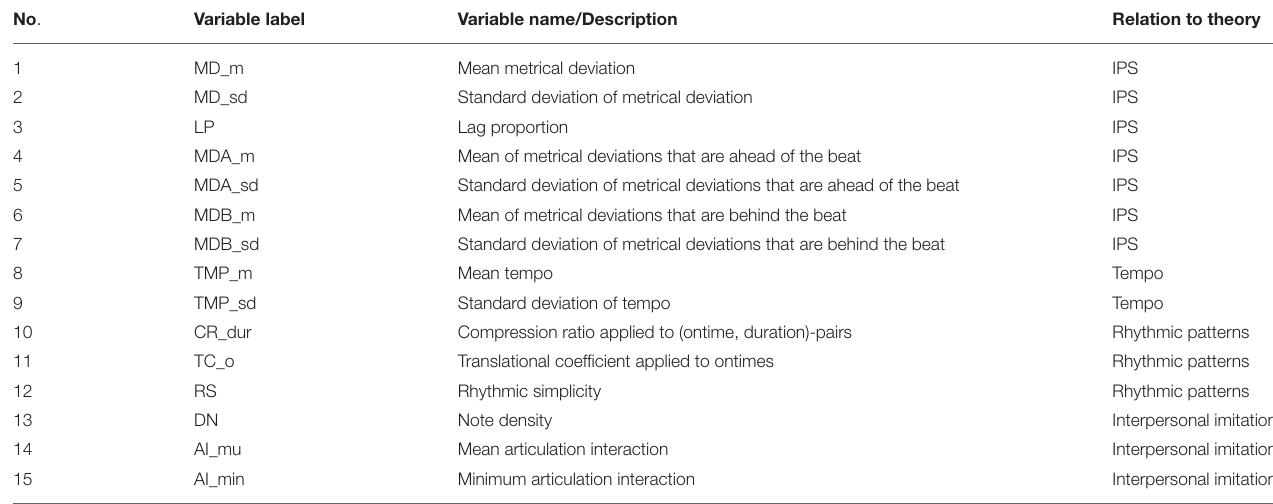
TABLE 1 | Summary of the MIR variables used to quantify aspects of a participant’s playing in the accompanied improvisation. No